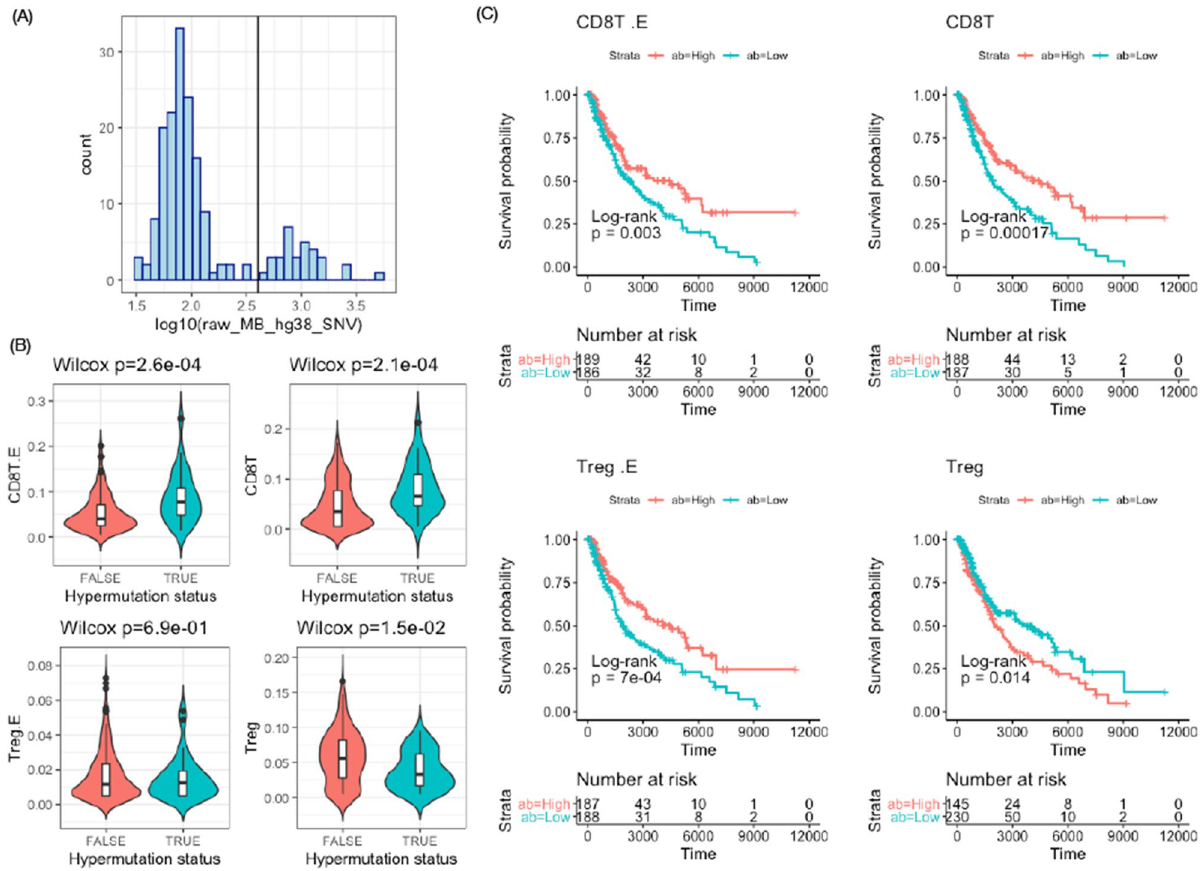
Figure 5. Association analysis for cell type proportions. ( A ) The distribution of mutation loads across colon cancer patients. The vertical line indicates the cutoff to classify samples to be hypermutated. ( B ) Comparison of cell type proportions of the hypermutated samples versus non-hypermutated colon cancer samples. The cell proportions estimated by gene expression are labeled by a suffix “.E”. ( C ) Associations between survival time and cell type proportions for melanoma patients. All the samples are divided into two groups based the median of cell type proportion estimates (abundance/ab high or low). More than half of the Treg proportions (estimated by DNA methylation) are 0’s and thus the group of “ab high” is less than 50% of the samples. These plots were generated using ggplot2 version 3.3.1 24 and survminer 0.4.8 32